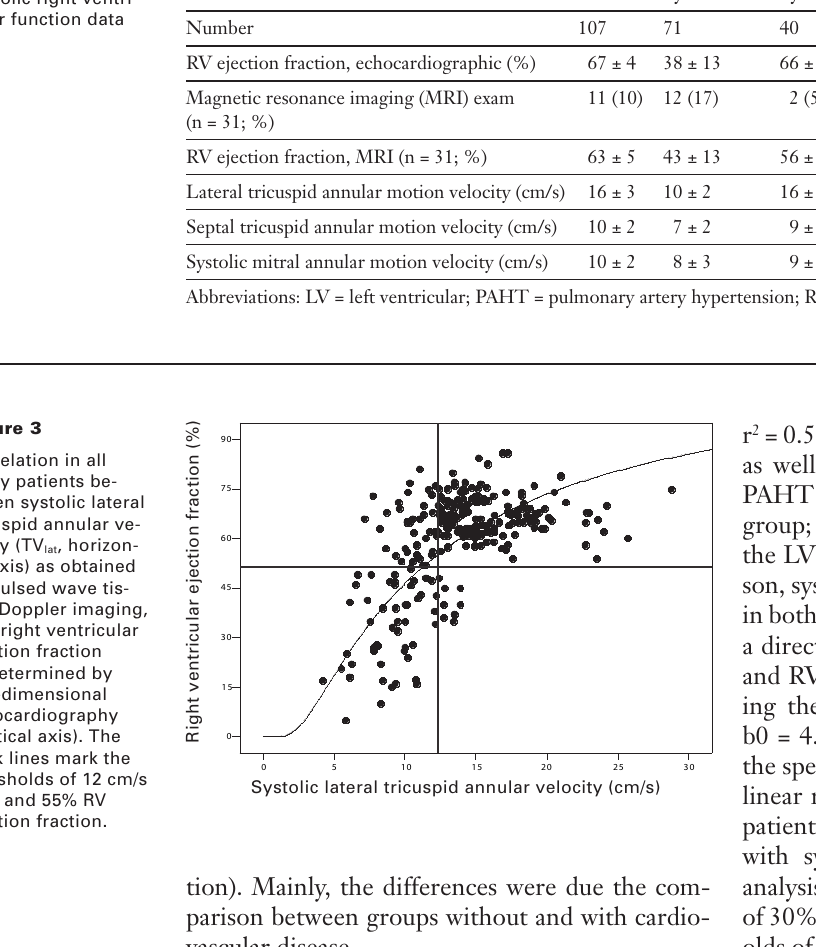
Systolic right ventri- cular function data